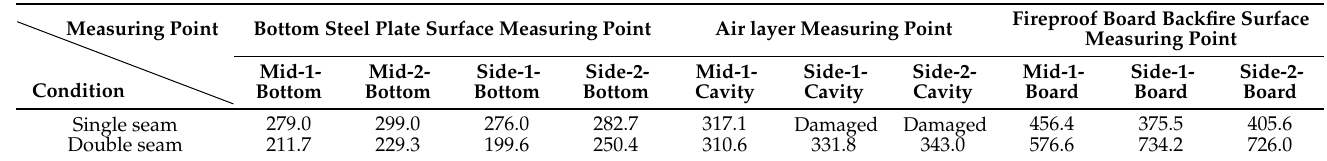
Table 2. Maximum temperature of the measuring points in the cavity behind the fireproof board.